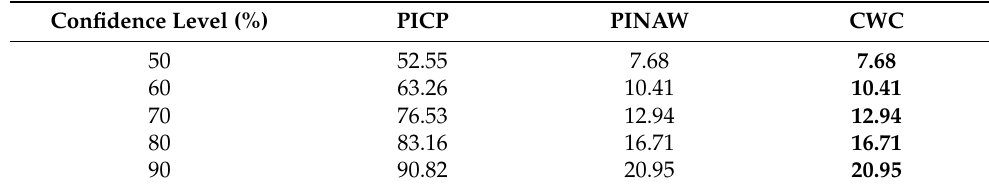
Table 3. Three-hour-ahead Predicted Intervals (PIs) using the proposed model that considers WRFD, RWRF, and WEPS.